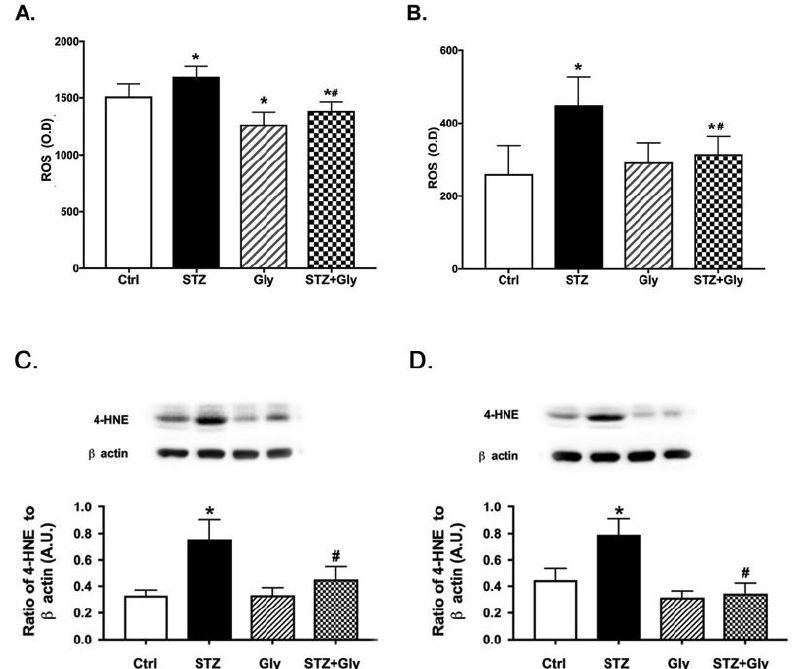
Figure 4. Reactive oxygen species (ROS) measurement in diabetic mice. ( A ) is at two months and ( B ) is measurement of ROS in control mice (Ctrl), control mice treated with glycyrrhizin (Gly), diabetic mice (STZ), and diabetic mice treated with glycyrrhizin (STZ + Gly). ( C , D ) show 4-HNE levels in the same groups. * p < 0.05 vs. ctrl, # p < 0.05 vs. diabetes. n = 5 for each group.